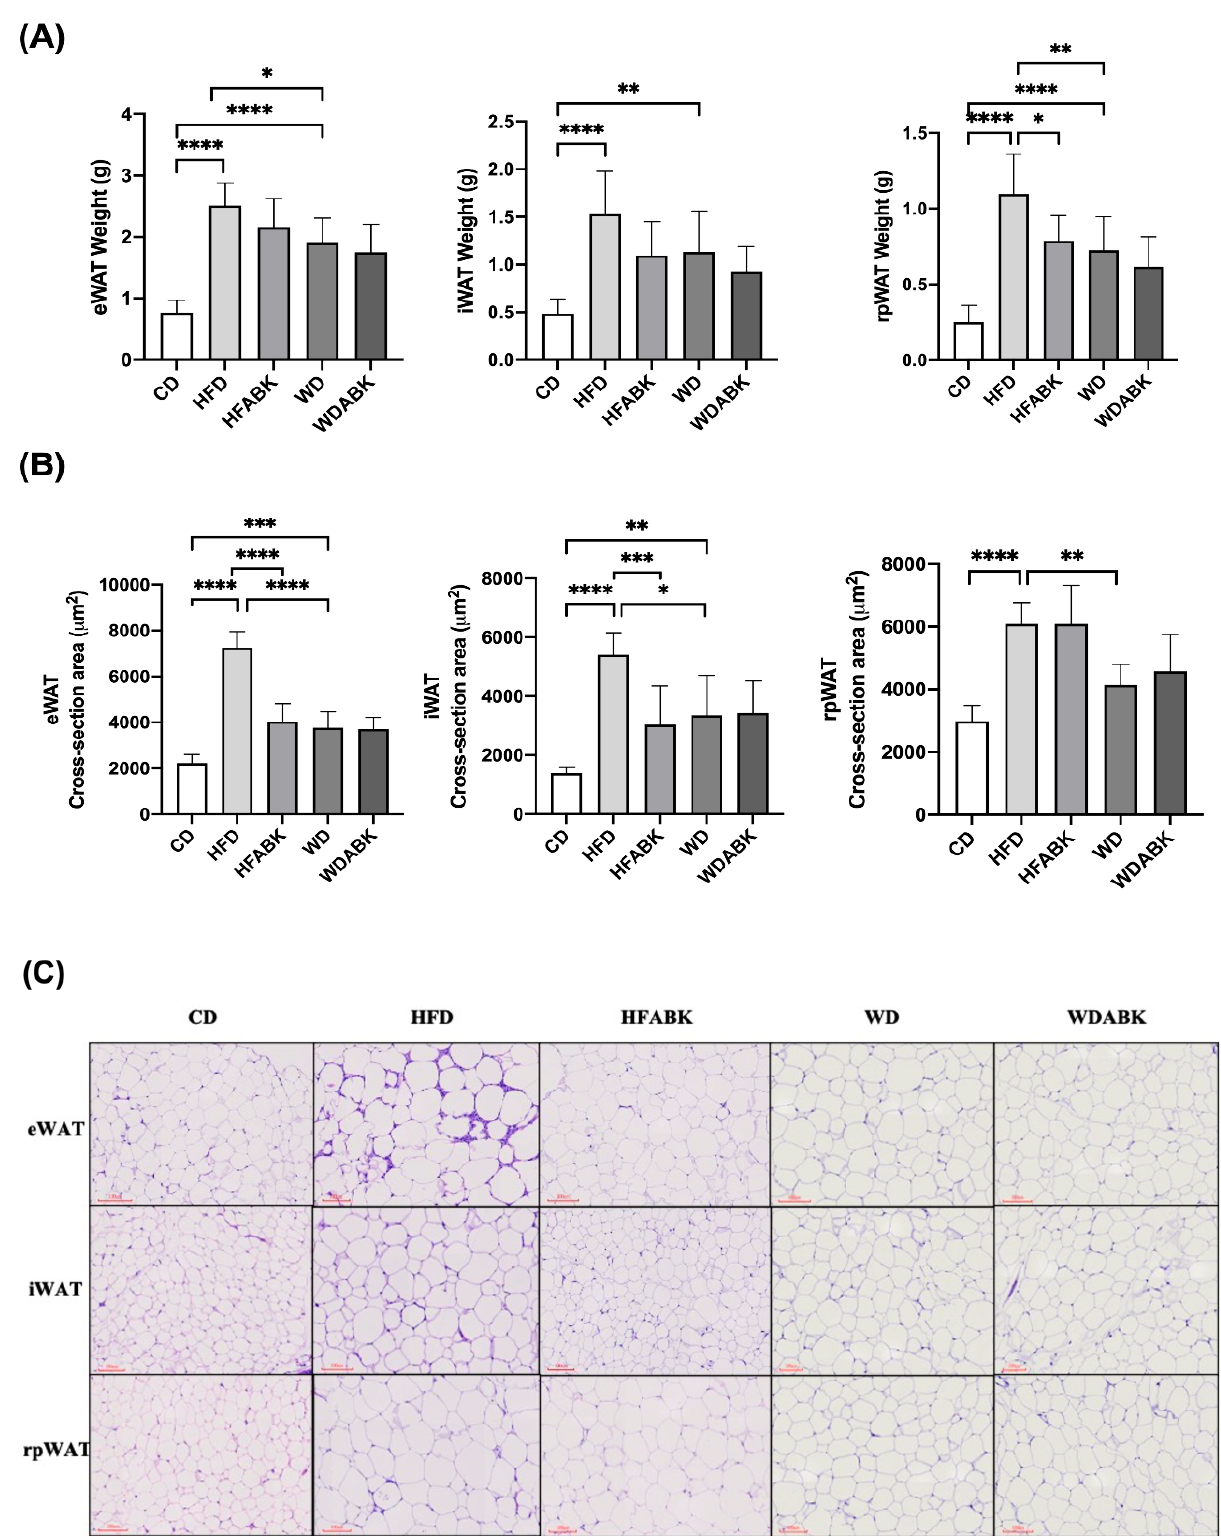
Figure 4. Effect of AB-Kefir on adipogenesis of white adipose tissue (WAT) in HFD- and WD-fed mice. ( A ) Weight and ( B ) cross-sections of epididymal, inguinal, and retroperitoneal WAT are shown. ( C ) H&E staining of representative histological sections of the WAT tissues. Scale bar = 100 μ m. Data are expressed as mean ± S.D. (n = 8 per group) * p < 0.05, ** p < 0.01, *** p < 0.001, **** p <0.0001. Statistics were analyzed by using one-way ANOVA with Tukey’s post hoc test.